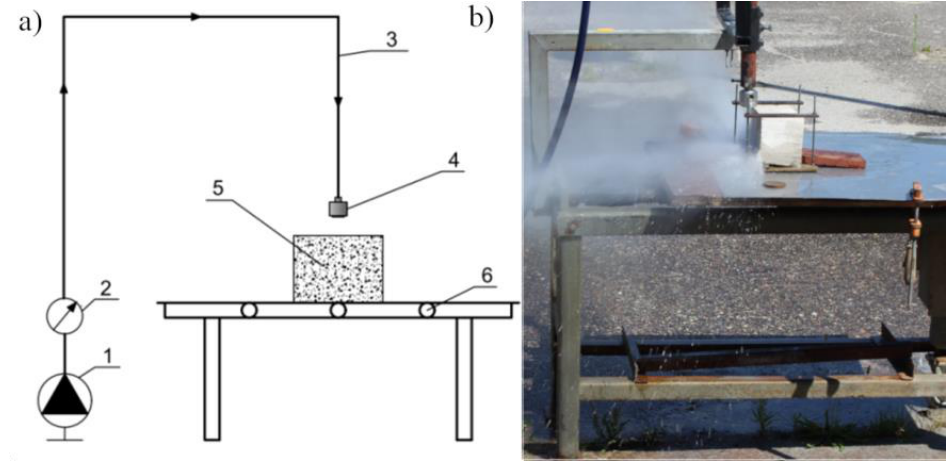
Figure 11. Stand for testing water jet erosivity: ( a ) stand diagram: 1 − monitor unit, 2 − manometer,